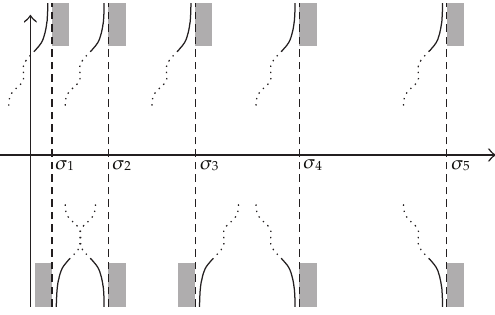
Figure 2: Bifurcation diagram for g (cid:3) s (cid:4) (cid:5) e − (cid:3) s − 0 . 15 (cid:4) 2